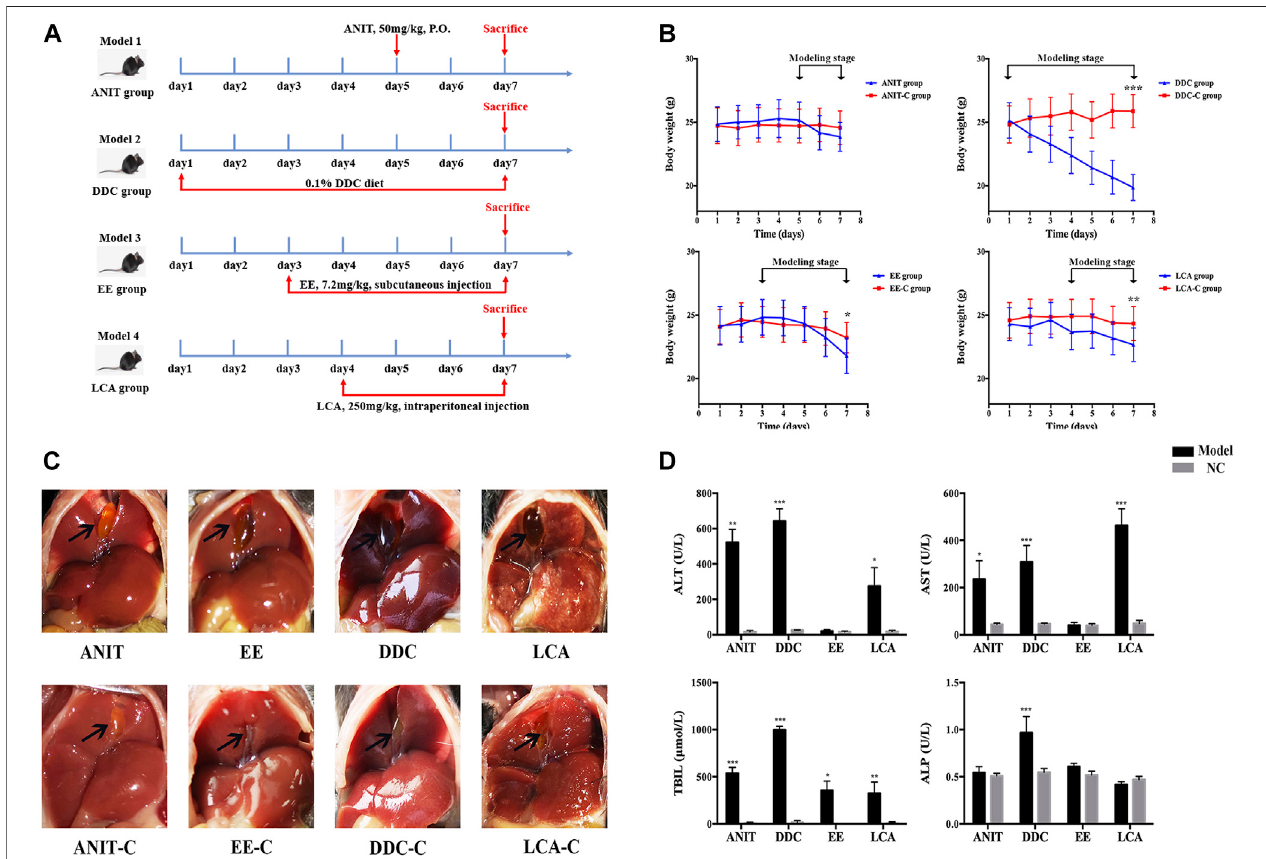
FIGURE 1 | Acute intrahepatic cholestasis murine models induced by ANIT, DDC, EE and LCA. (A) Experimental protocols to establish the four models. (B) The body weight of mice in each group were evaluated daily. (C) Photographs ofrepresentative livers. Gall bladders are marked by arrows. (D) The data of serum ALT, AST, TBIL and ALP indicate liver injury and cholestasis in all four murine models. Data are the mean ± S.D. (n = 8). * p < 0.05 versus Control, ** p < 0.01 versus Control, *** p < 0.001 versus Control.